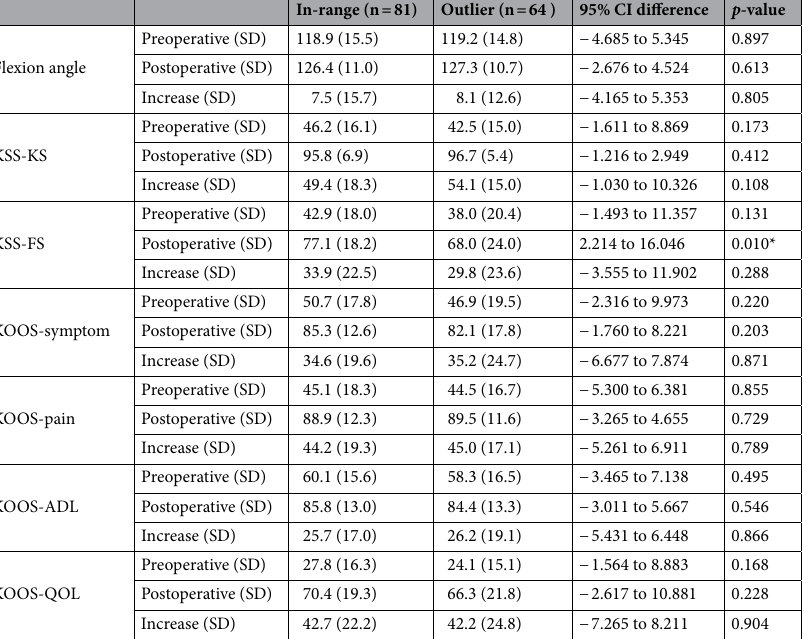
Table 2. Comparison of clinical scores and patient-reported outcomes between groups for the HKA. HKA, hip-knee-ankle; KSS, Knee Society Score; KS, Knee Score; FS, Function Score; KOOS, Knee injury Osteoarthritis Outcome Score; SD, standard deviation; CI, confidence interval. *Significant difference, p <